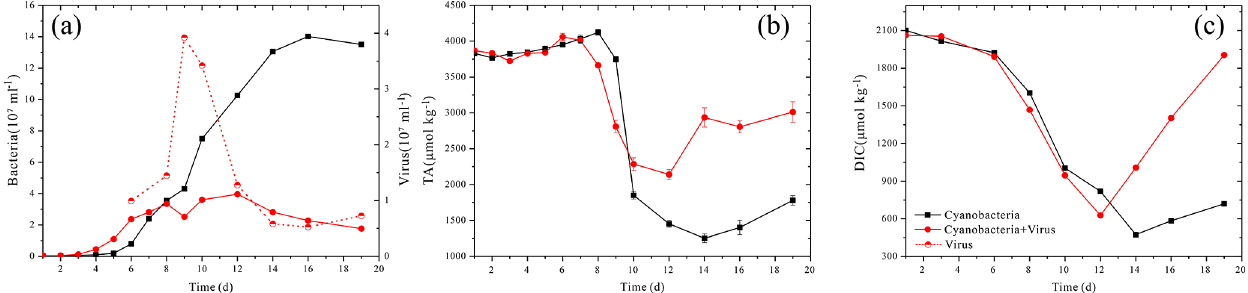
Figure 2. Changes in the solution’s bacteria and virus concentration (a) , total alkalinity (TA) (b) and dissolved inorganic carbon (DIC) (c) .